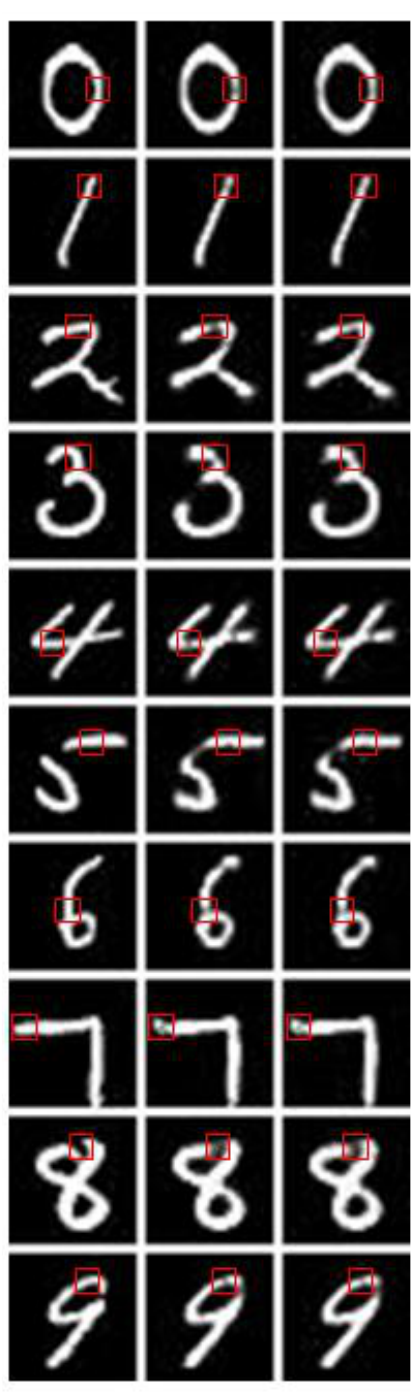
Figure 17. Marked reconstruction images on the MNIST data set. The recovery images on the MNIST data set are shown in Figure 16. For each subfigure in Figure 16, the top row shows the original images, the middle row shows the recovery images of AE, and the bottom row shows the recovery images of RCDAE. It is not easy to find the SSIM differences between AE and RCDAE in Figure 16. Therefore, the marked re-establishment images on the MNIST data set are illustrated in Figure 17. The left column shows the original images, the middle column shows the re-establishment images of AE, and the right column shows the re-establishment images of RCDAE. It is easy to notice the SSIM differences between AE and RCDAE in the red marked squares in Figure